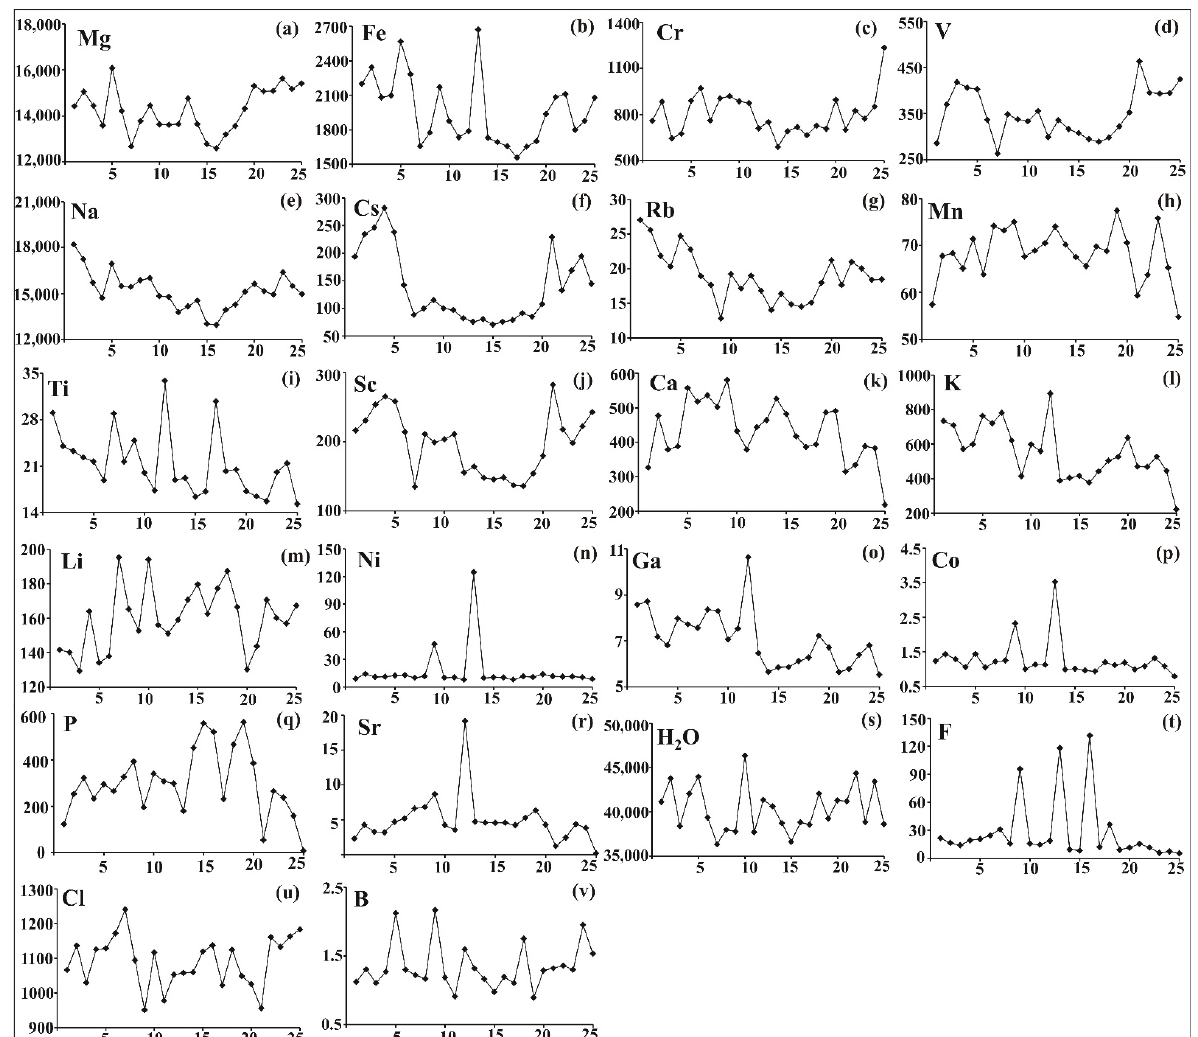
Figure 4. Zoning of the distribution of trace and minor elements (ppm) in the analyzed beryl from Wadi Nugrus, South Eastern Desert, Egypt. ( a ) Mg in (ppm); ( b ) Fe in (ppm); ( c ) Cr in (ppm); ( d ) V in (ppm); ( e ) Na in (ppm); ( f ) Cs in (ppm); ( g ) Rb in (ppm); ( h ) Mn in (ppm); ( i ) Ti in (ppm); ( j ) Sc in (ppm); ( k ) Ca in (ppm); ( l ) K in (ppm); ( m ) Li in (ppm); ( n ) Ni in (ppm); ( o ) Ga in (ppm); ( p ) Co in (ppm); ( q ) P in (ppm); ( r ) Sr in (ppm); ( s ) H 2 O in (ppm); ( t ) F in (ppm); ( u ) Cl in (ppm); ( v ) B in (ppm).